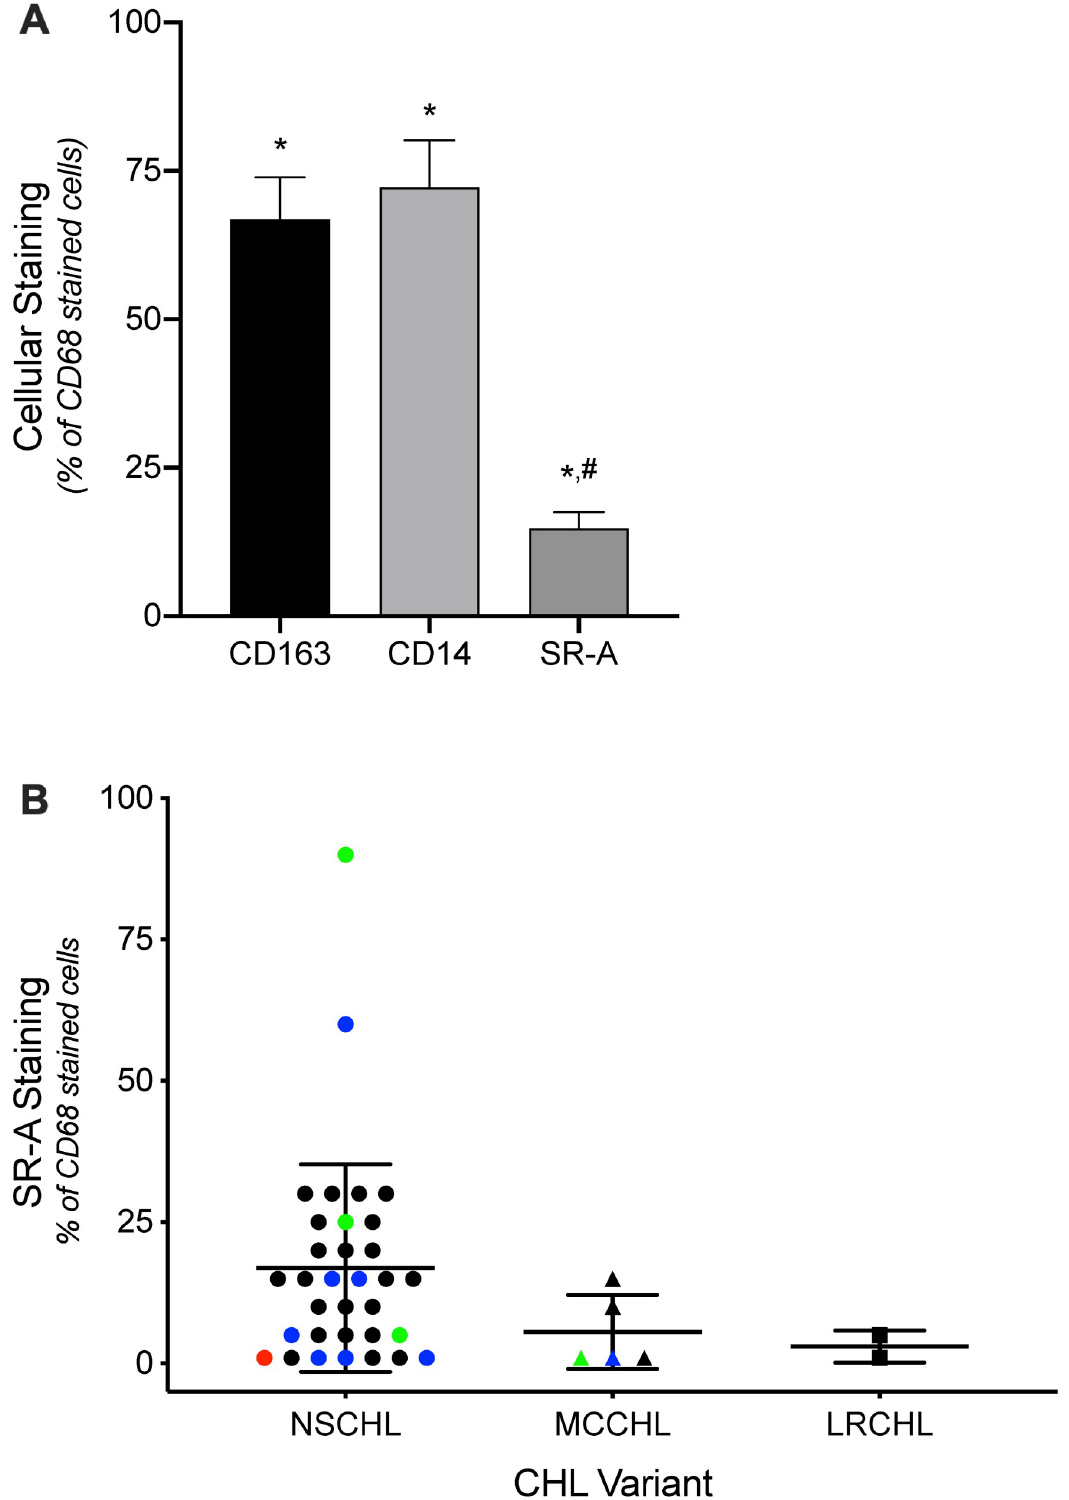
Fig 2. Analysis of CD163, CD14, and SR-A expression compared to CD68 in CHL lymph nodes. Tissue sections of nodal CHL stained with CD68, CD163, CD14, and SR-A (OTI9ES) were scored by a pathologist. (A) The graph depicts the percent of CD68 positive cells that were also stained with CD163, CD14, or SR-A. � denotes significant differences (p < 0.05) from CD68 assessed by